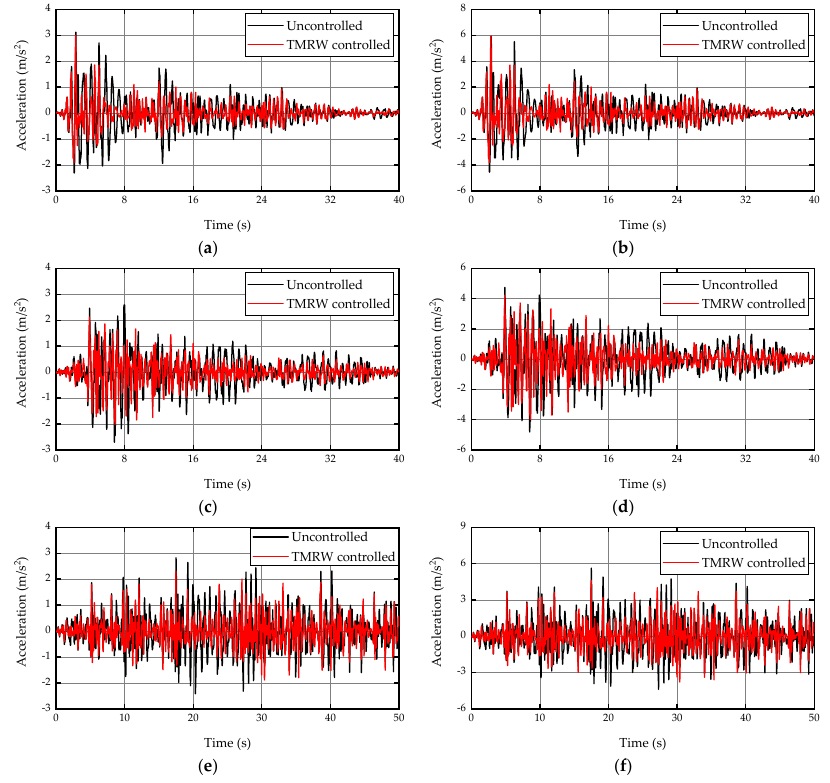
Figure 13. Comparison of the acceleration responses (the top floor): ( a ) El Centro earthquake excitation (0.1 g); ( b ) El Centro earthquake excitation (0.2 g); ( c ) Taft earthquake excitation (0.1 g); ( d ) Taft earthquake excitation (0.2 g); ( e ) Wenchuan earthquake excitation (0.1 g); ( f ) Wenchuan earthquake excitation (0.2 g).